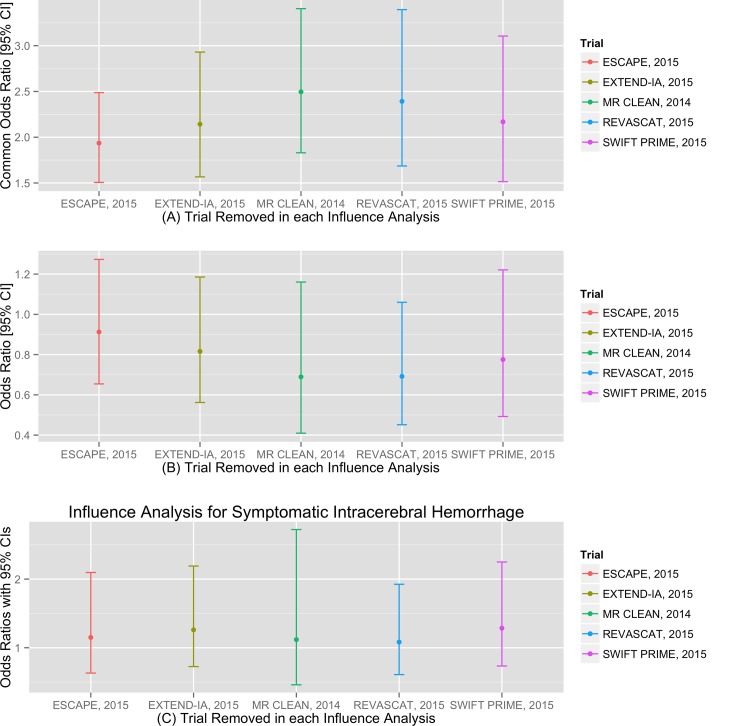
Influence analyses for pooled effects on primary and secondary outcomes.Removal of any single trial does not significantly influence the pooled effect of endovascular therapy on (A) the primary outcome of a beneficial shift in mRS score distributions, (B) the secondary outcome of mortality or (C) the secondary outcome of symptomatic intra-cerebral hemorrhage.